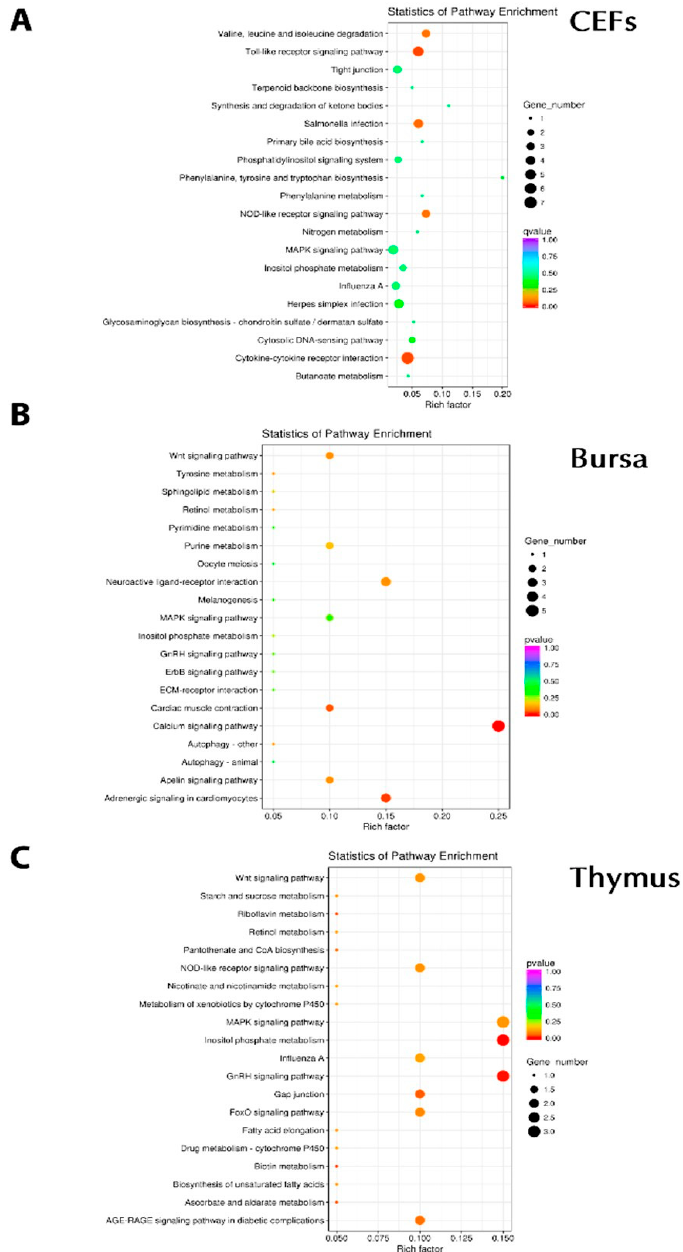
Figure 5. Pathway enrichment associated with chIFN- λ treatment. A : chIFN- λ -treated CEF. B : chIFN λ -treated bursa of Fabricius. C: chIFN- λ -treated thymus.